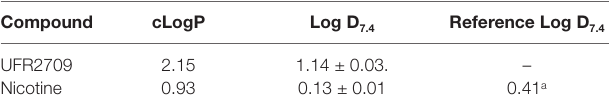
TABlE 1 | Theoretical (cLogP) and experimental lipophilicity of UFR2709 and Nicotine were determined using the octanol-buffer distribution coefficient at